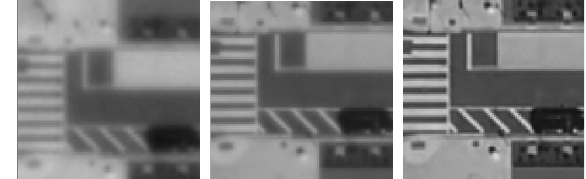
Figure 2 Left: Simulated LR image w/ noise, upsampled. Centre: Simulated HR image with the same PSF as the LR image, w/o noise. Right: Simulated HR target.